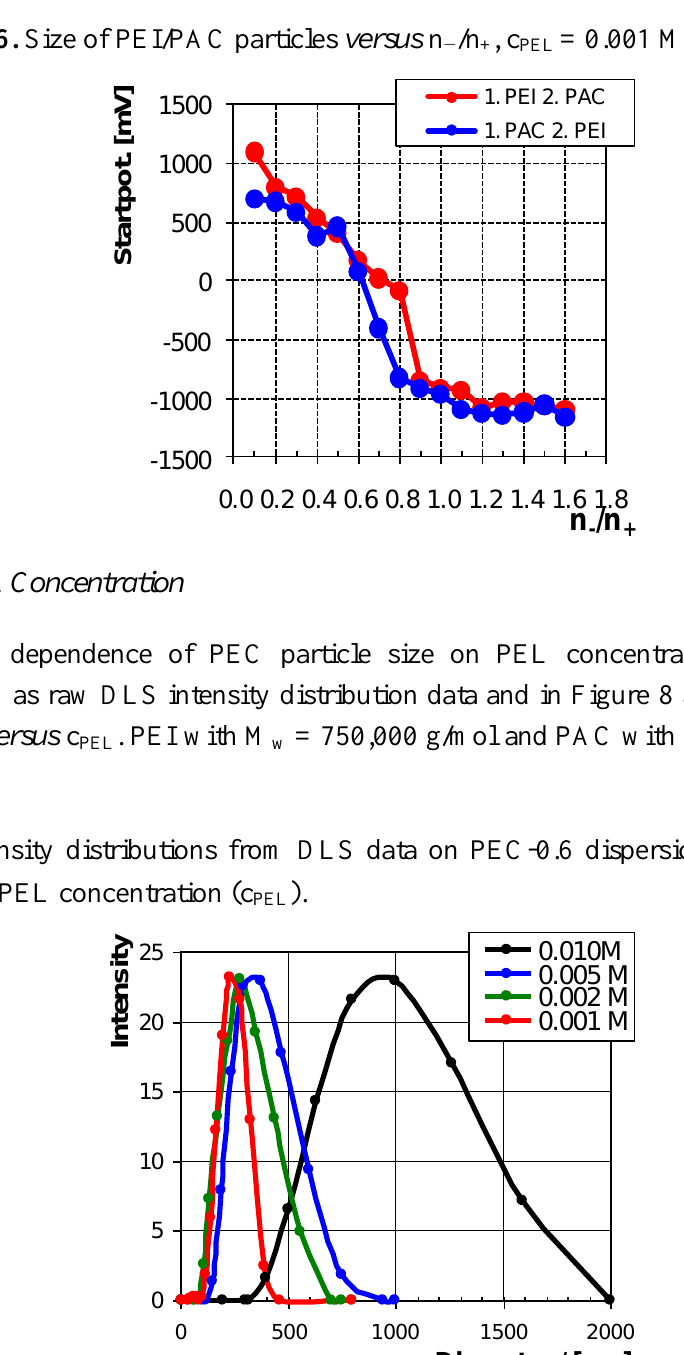
Figure 6. Size of PEI/PAC particles versus n